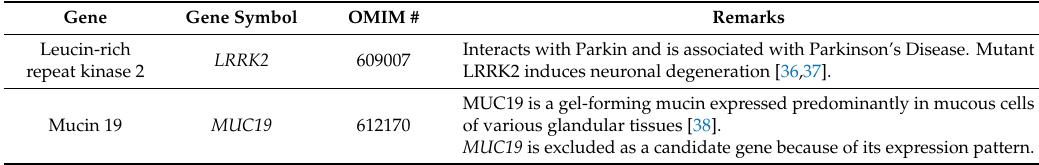
Table 1. Genes involved in DGDP289A with 12q12